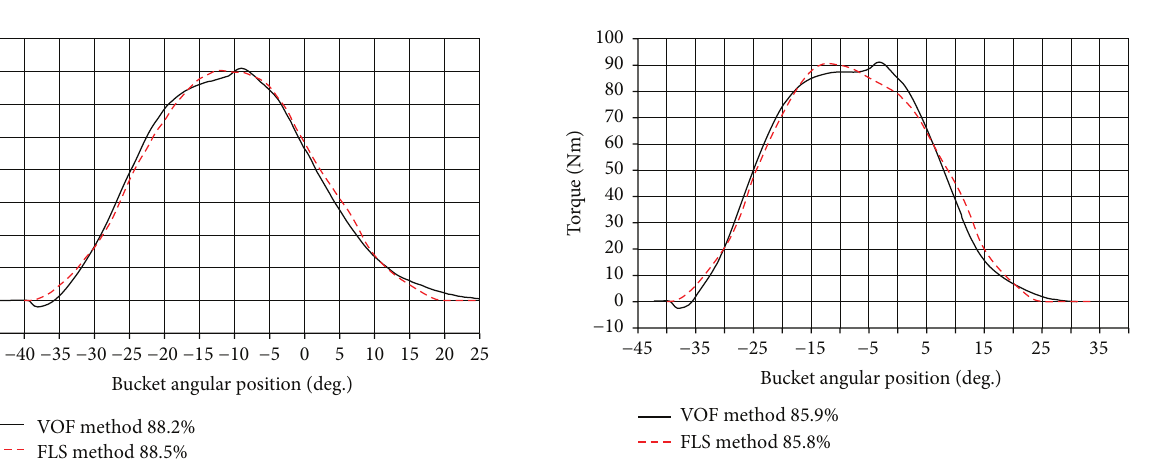
Figure 16: Comparison of VOF and FLS methods for higher hydraulic head.